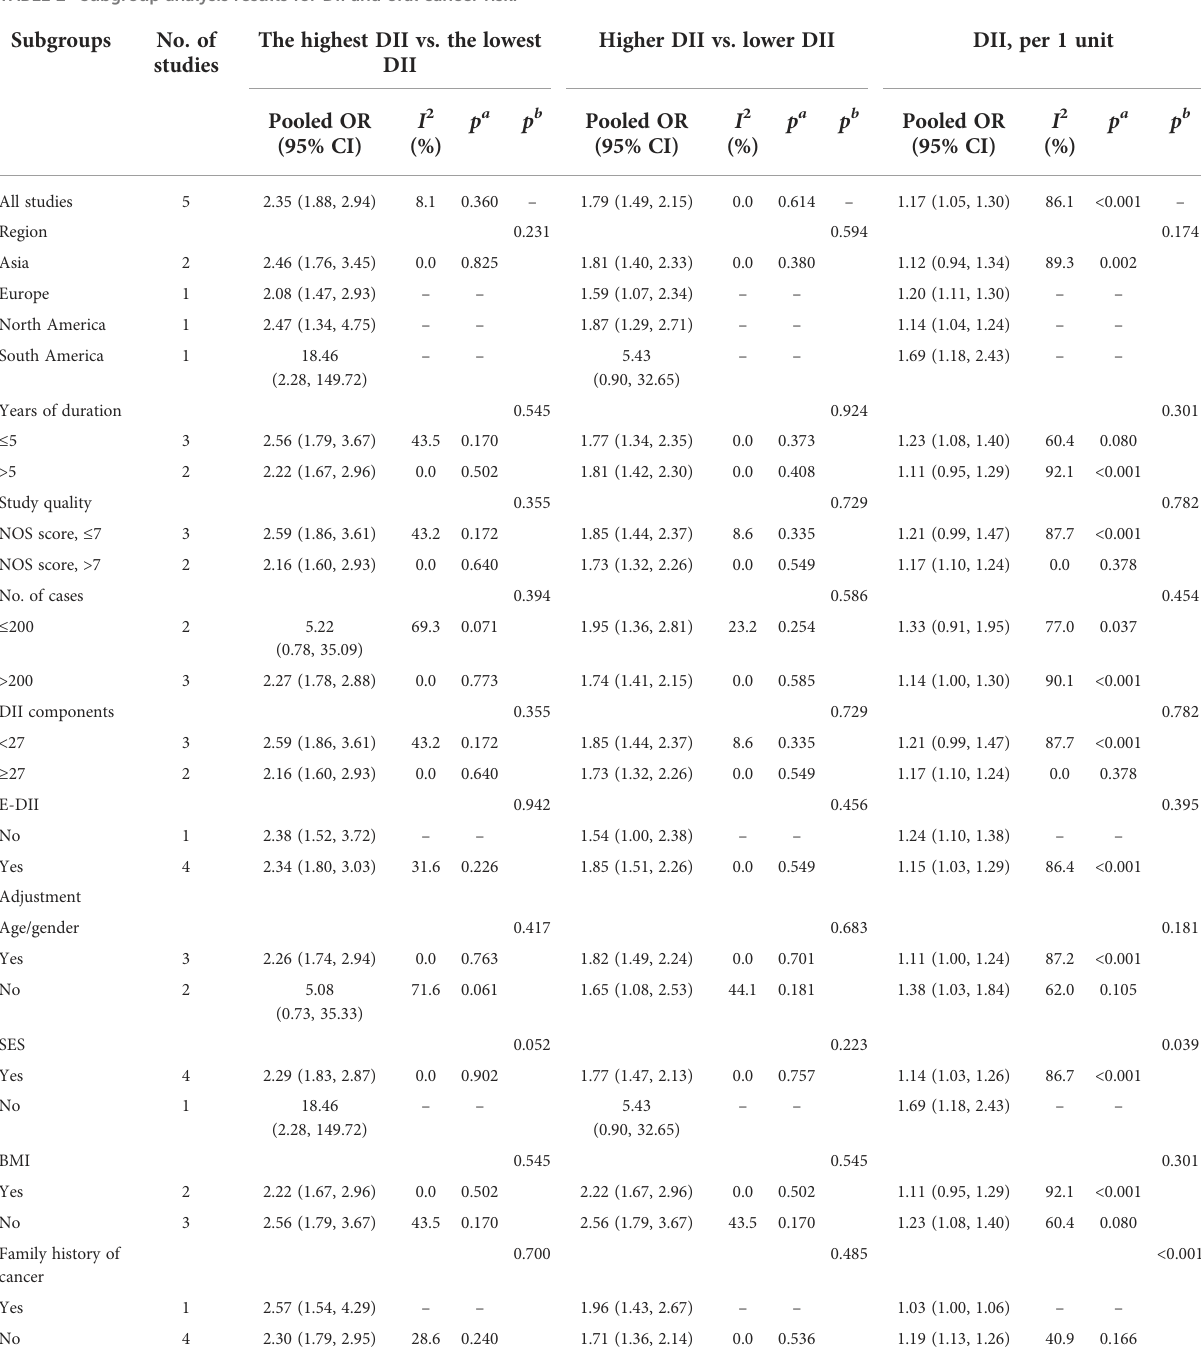
TABLE 2 Subgroup analysis results for DII and oral cancer